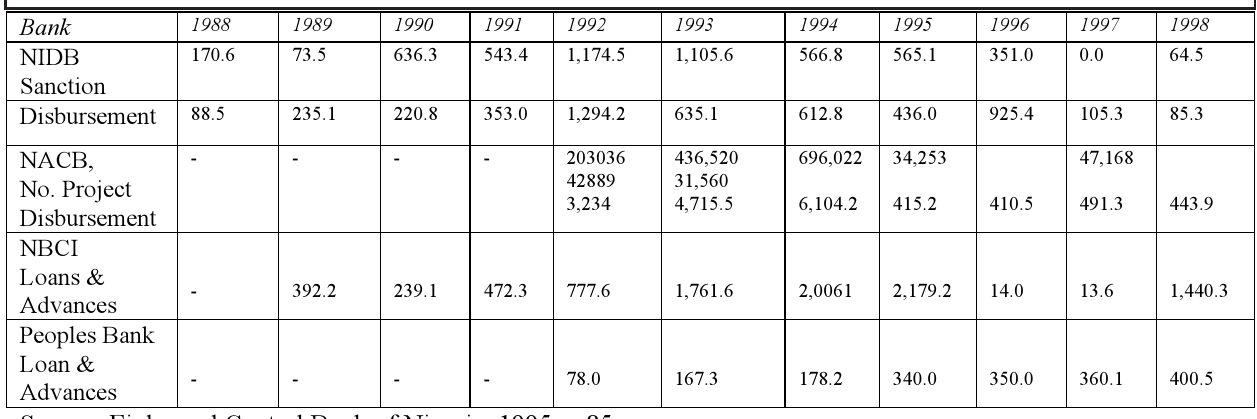
Table 1. Summary of Lending Activities of Selected Financial Institution from 1988–1998 (